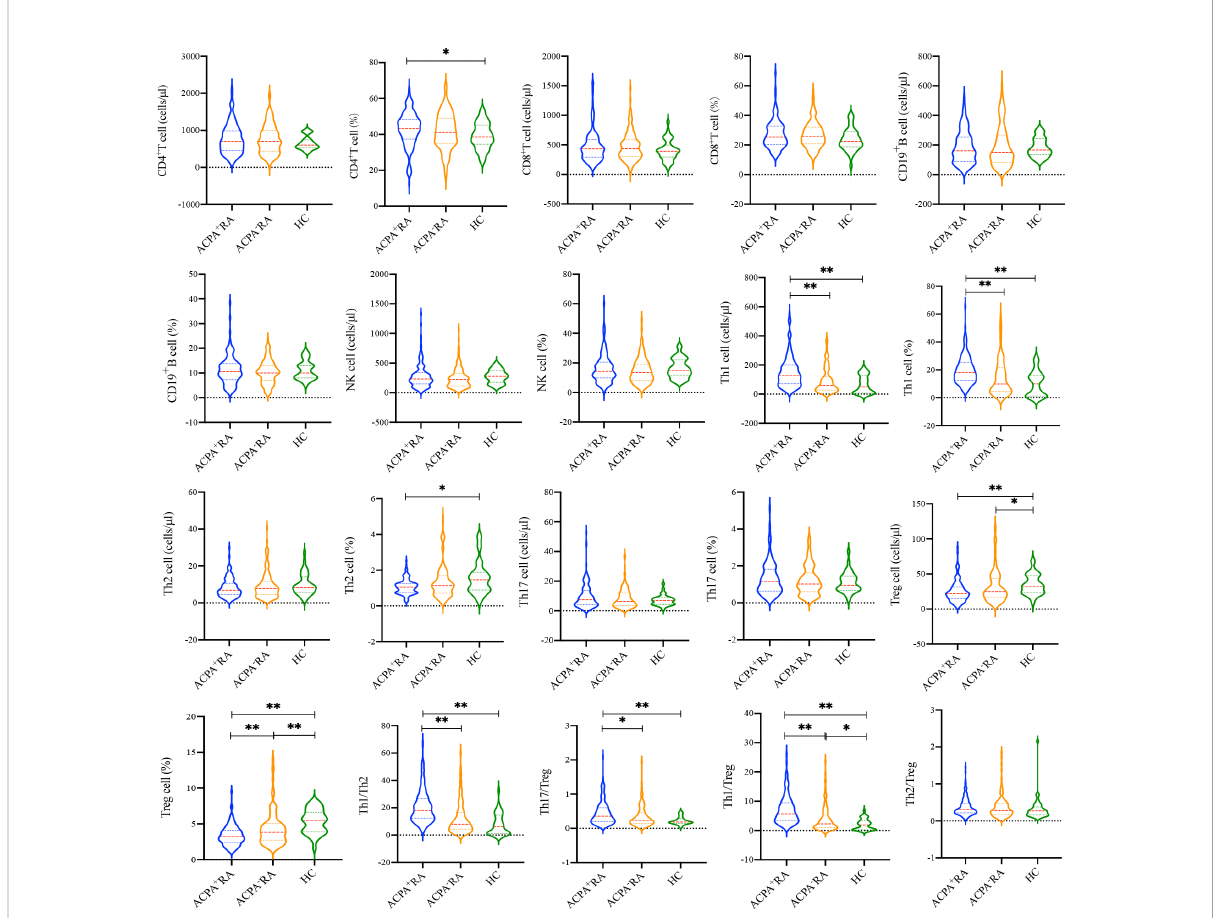
FIGURE 2 Comparison of the lymphocyte subsets and CD4 + T cell subsets between ACPA + RA, ACPA - RA patients and HCs. * p < 0.05, ** p <